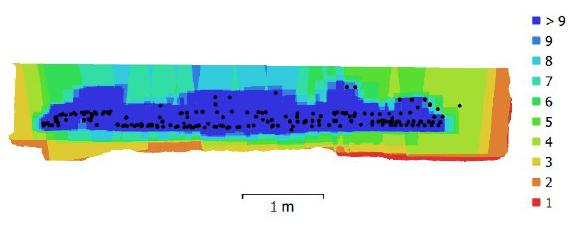
Figure 3. Main wall: overlapping cameras as displayed in the PhotoScan